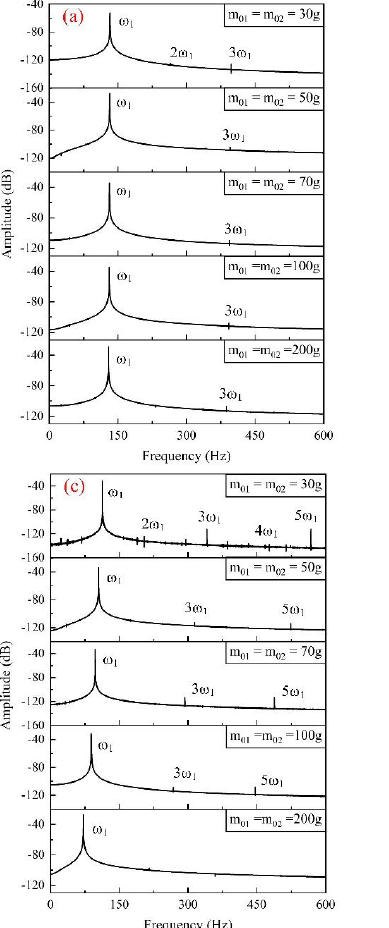
in l /2. ( c ) Symmetric additional masses (top to bottom: 30 g, 50 g, 70 g, 100 g, and 200 g) in l × 3/4.